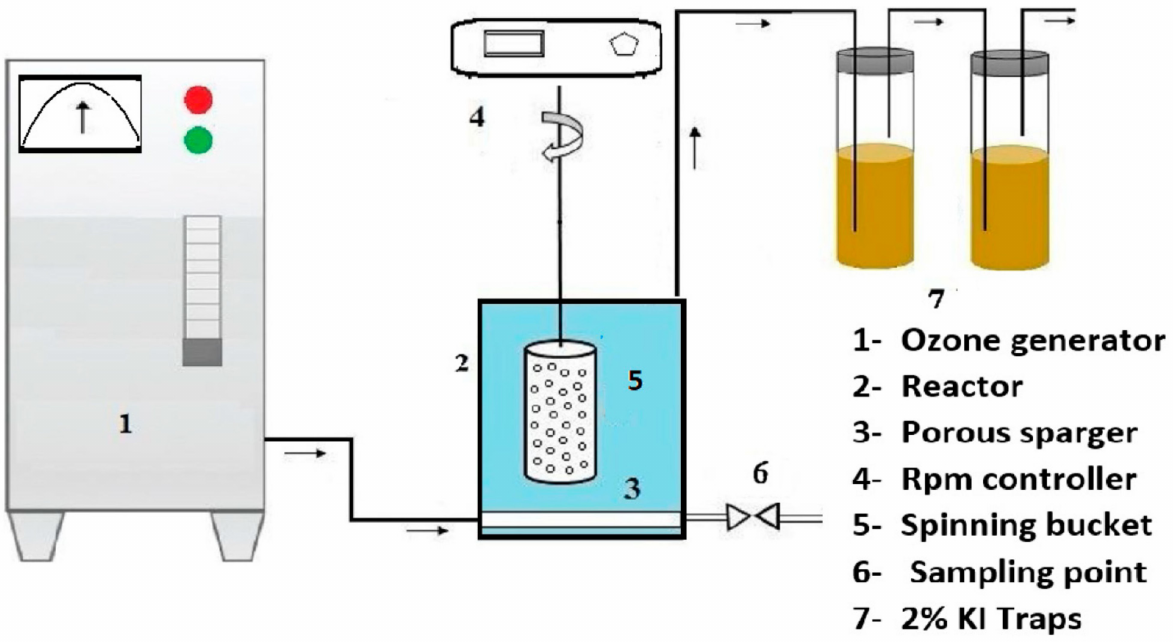
Figure 1. Schematic diagram of the process with a modified batch reactor